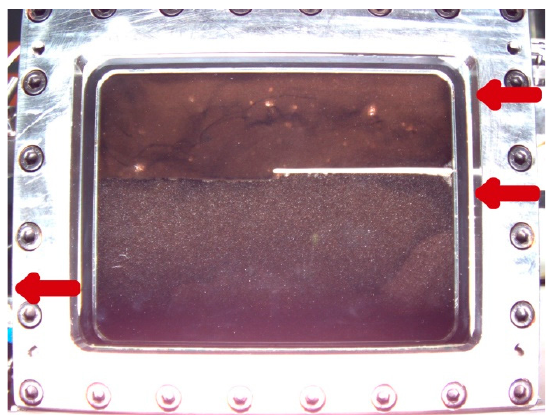
Figure 3. Schematic diagram of the injection-production mode of the 2D double-layer heterogeneous visualization model. (The arrow at the right side is the injection end; the arrow at the left side is the production end).